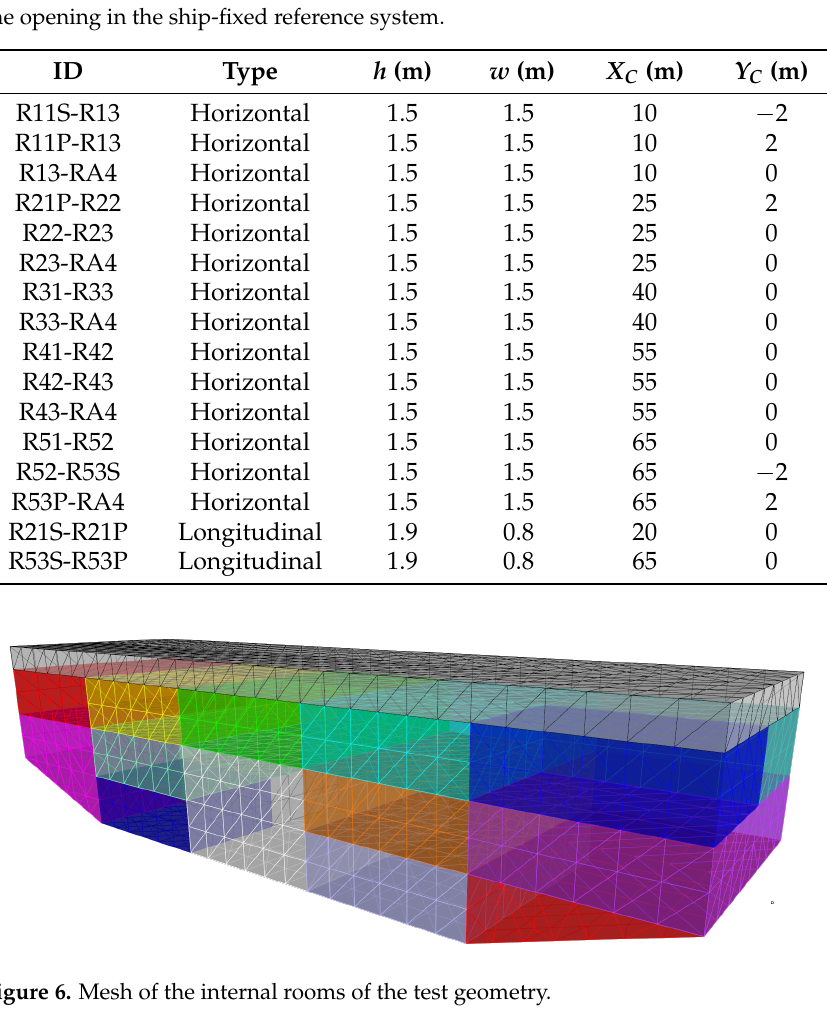
Figure 6. Mesh of the internal rooms of the test